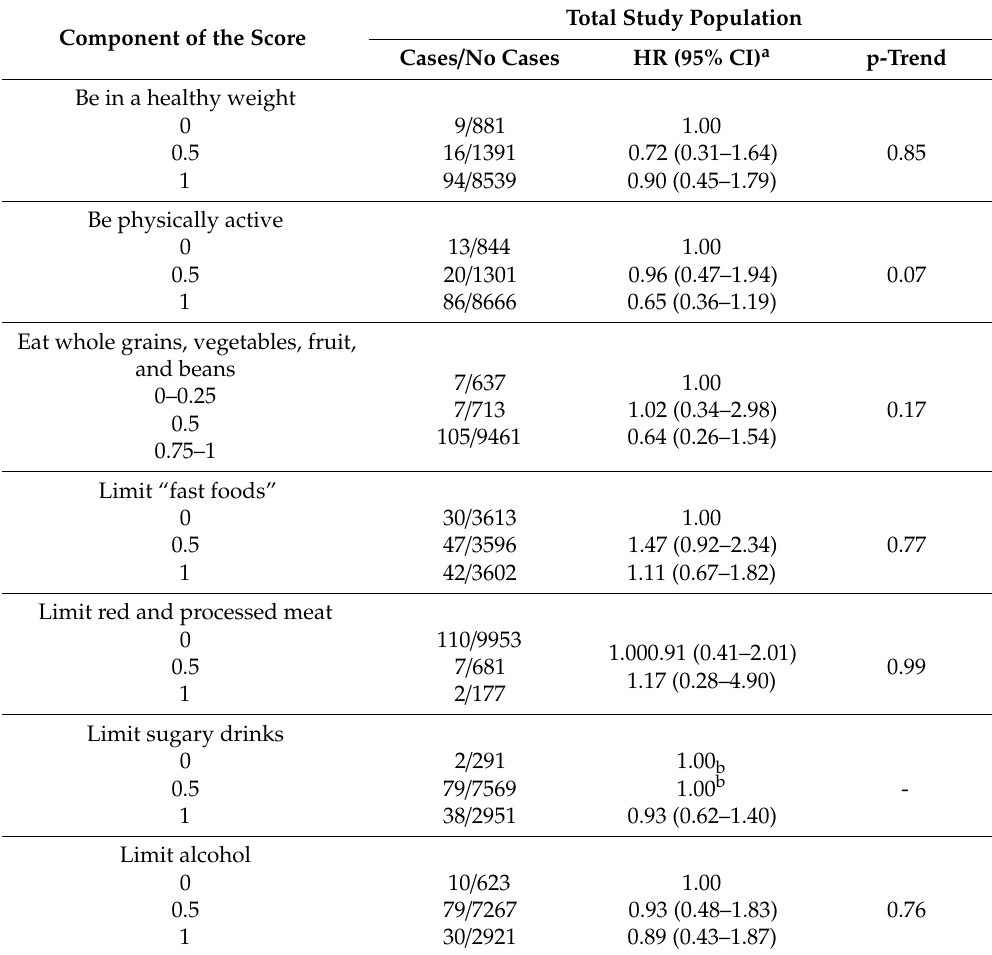
Table 3. Associations between adherence to individual components of the WCRF / AICR score and overall breast cancer